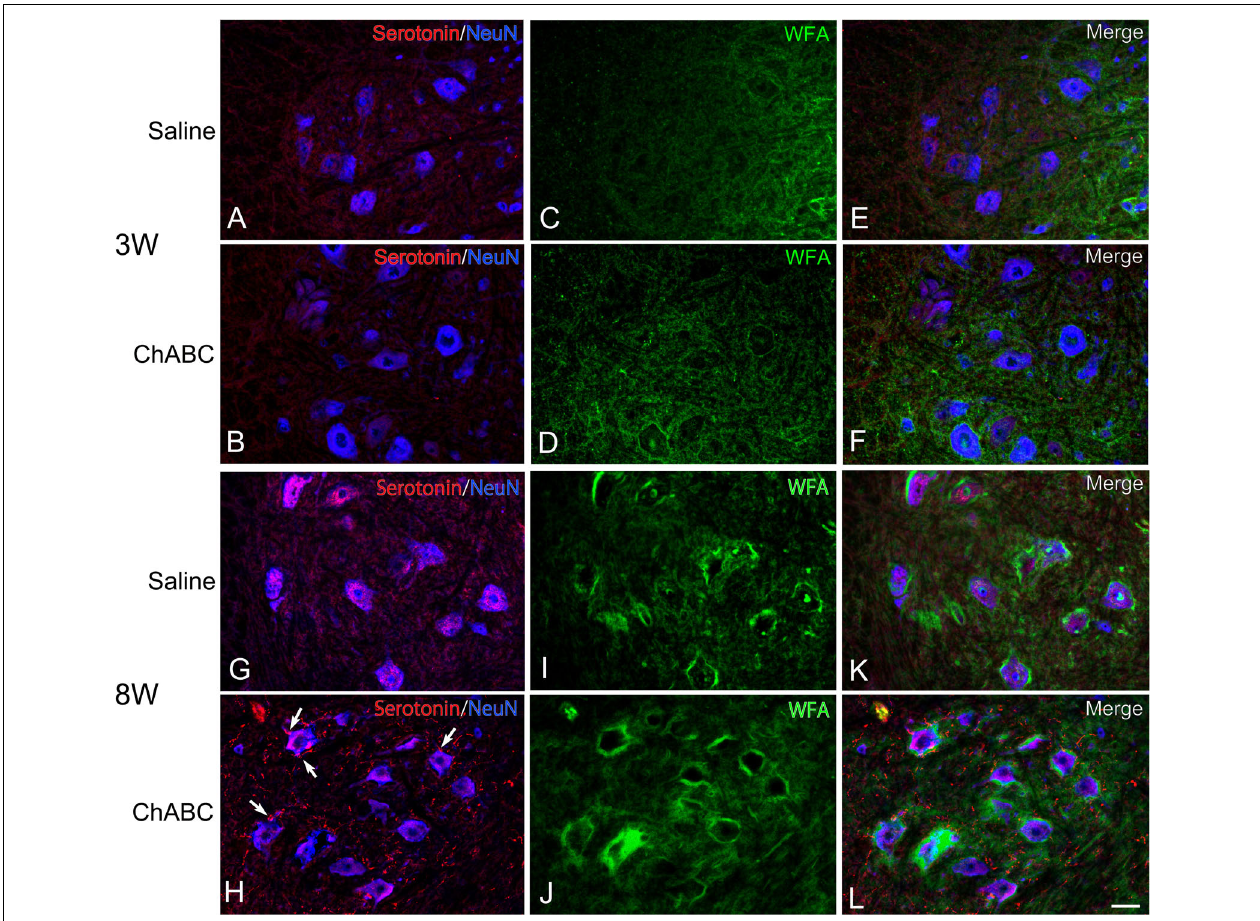
FIGURE 6 | Images of Wisteria Floribunda agglutinin (WFA) histochemistry (green), and immunohistochemistry for NeuN (converted to blue), and 5-HT (red) in the L5 ventral horn of rats with saline (A,C,E,G,I,K) , and ChABC (B,D,F,H,J,L) administration after 3 (A–F) and 8 (G–L) weeks after CST. Double-labeled images of 5-HT and NeuN (A,B,G,H) , WFA histochemistry images (C,D,I,J) , and merged images (E,F,K,L) are shown. Arrows in (H) indicate 5-HT nerve terminals on NeuN-positive motoneurons. Many 5-HT varicosities were also observed in (H,L) . Scale bars = 50 µ